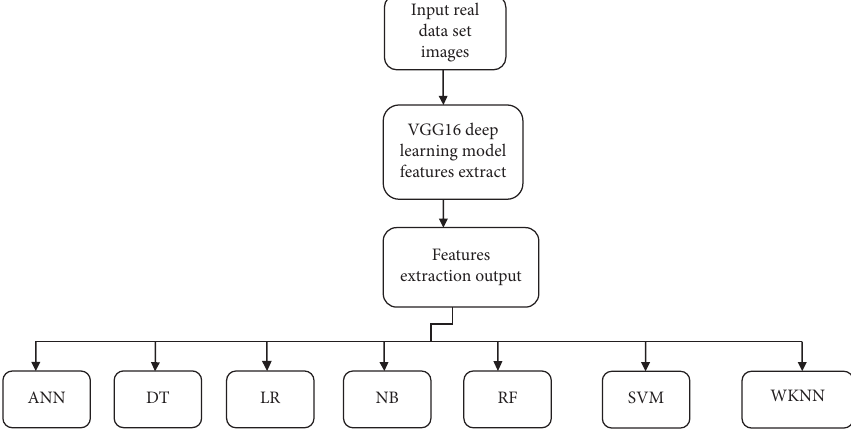
Figure 1: New proposed hybrid learning approach. Table 1: VGG-16 architecture